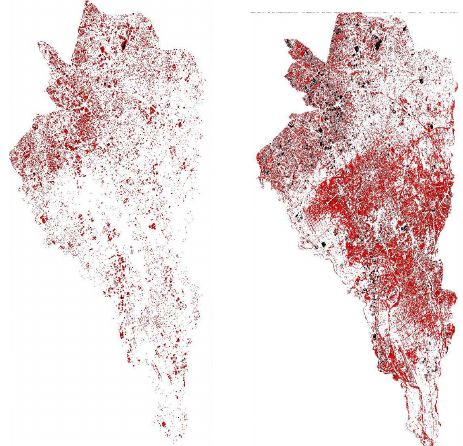
Figure 3. HyMAP RXD-UTD detail of anomalies (up left) and OSPRX (up rigth) of the San José test site, 4 m pixel size. MASTER RXD (down left) detail of anomalies and DATB anomalies (down right) for the same semi-urban area of San José.